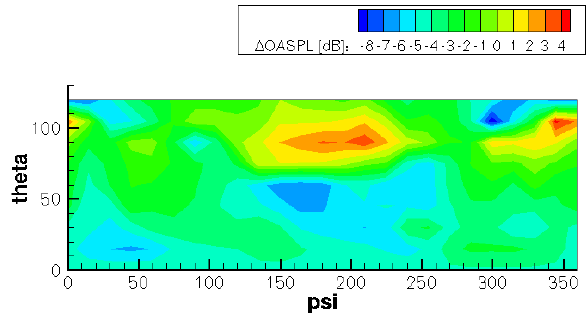
Figure 10: Technique A – C differential OASPL at point 1in maneuver